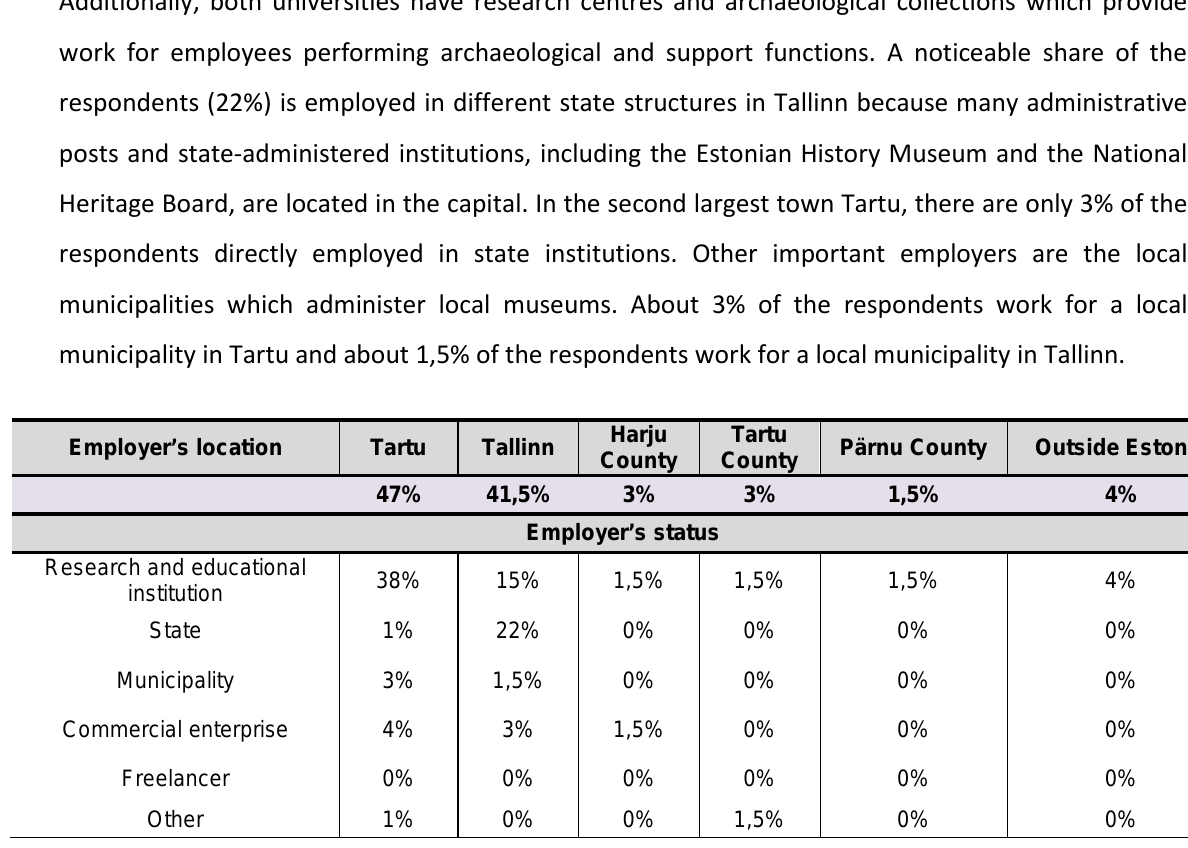
Table 2 - Comparison of the status and location of employers